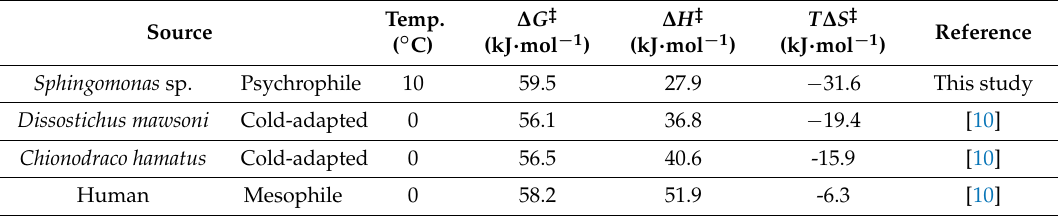
Table 4. Comparison of the thermodynamic parameters of G6PD enzymes.